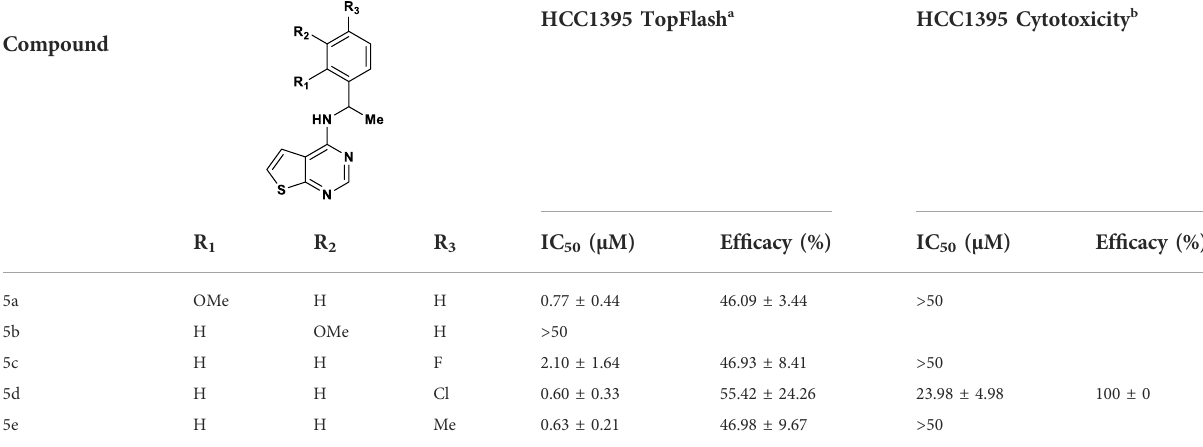
TABLE 2 SAR exploration of the 1-phenylethylamine top part of thieno[2,3-d]pyrimidine.